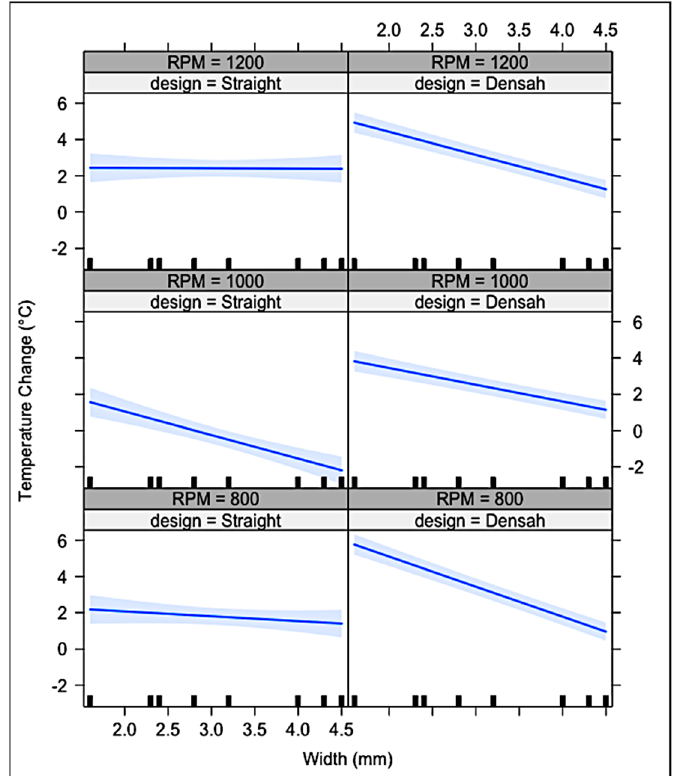
Figure 9. The Y-axis shows the temperature change ( ΔΤ ), and the X-axis shows the drill width. At all RPM, as drill diameter increased in Densah ® burs, ΔΤ decreased. The aforementioned pattern was seen only at 1000 RPM for the MIS ® straight drills. The 95% confidence interval did show that ΔΤ did not exceed the critical threshold of 47 °C in both systems.